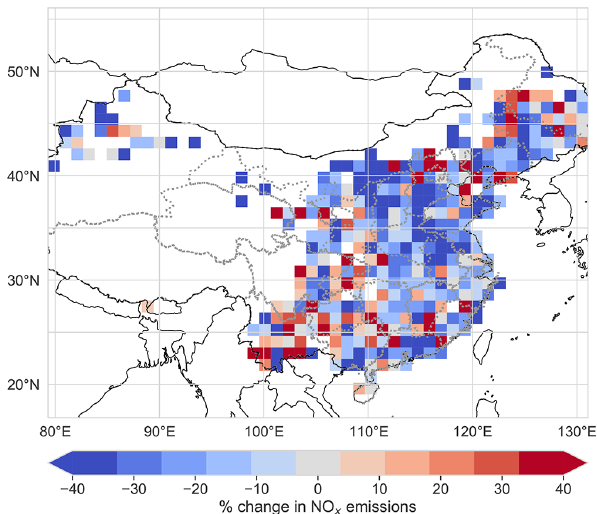
Figure 12. DL-estimated percent changes in Chinese NO x emis- sions averaged 20–30d after the 2020 CNY compared to 20–10d before the 2020 CNY. Results for grid boxes with NO x emissions less than 1 × 10 − 11 kgNm − 2 s − 1 are not